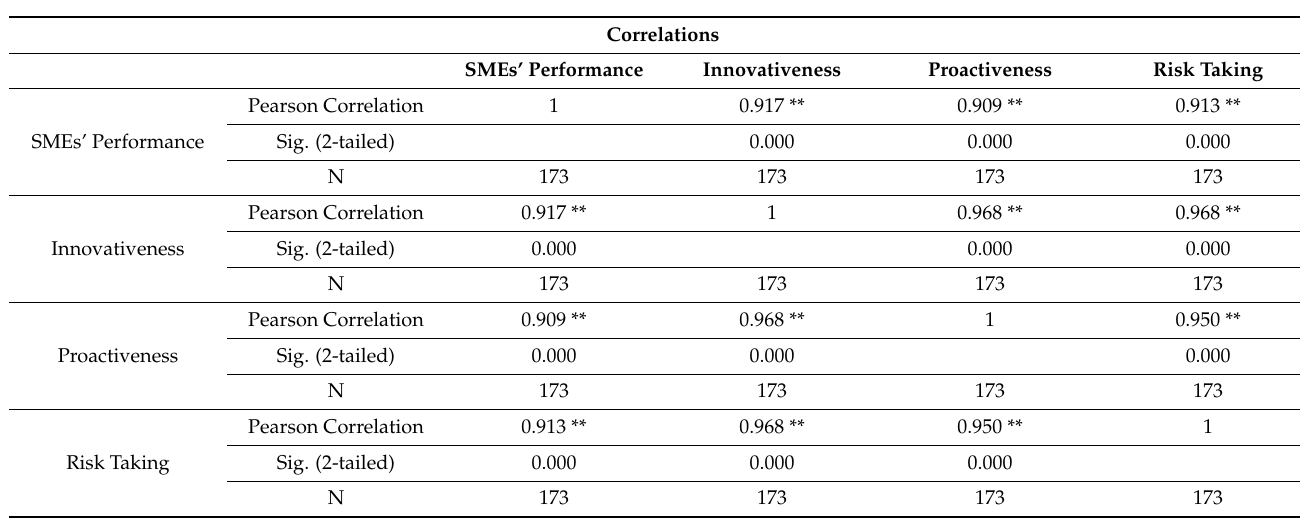
Table 8. Table of correlations.